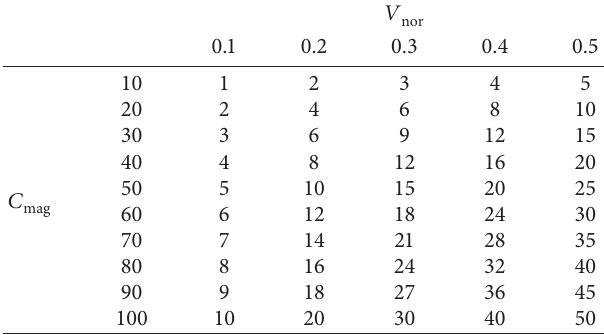
) for each set of thr